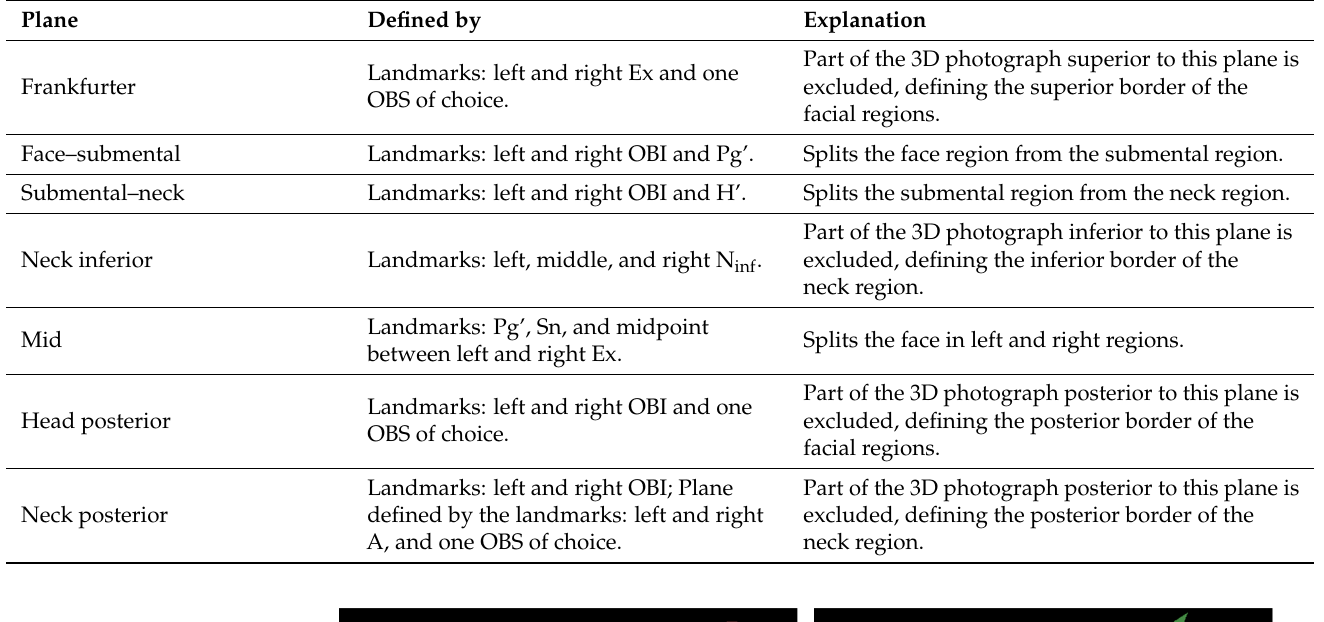
Table 3. Planes for splitting 3D photographs into right face, left face, submental, and neck regions.